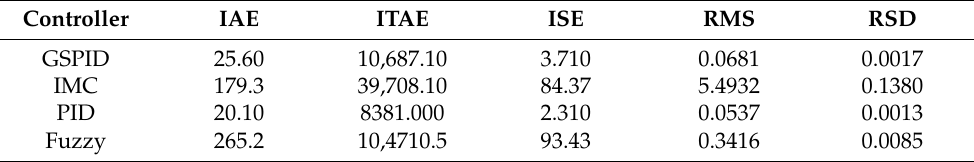
Table 8. Controller performance indexes for random disturbance in tank input